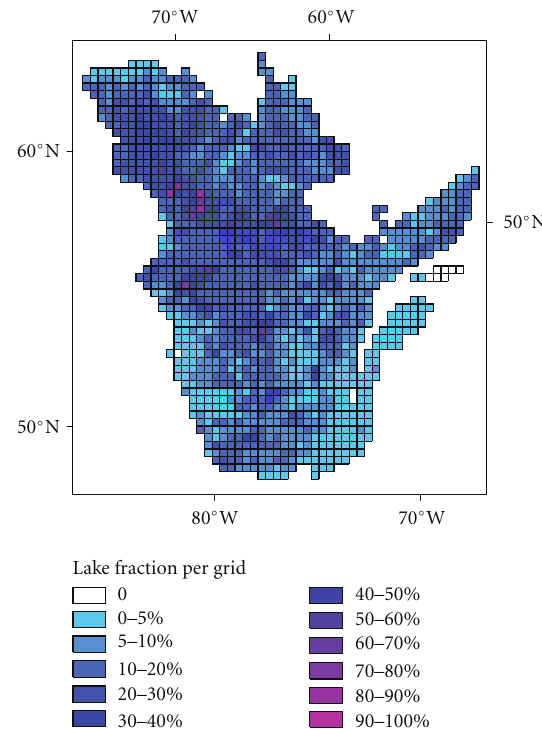
Figure 2: Lake fraction throughout the province of Quebec, represented by 32 km resolution grid